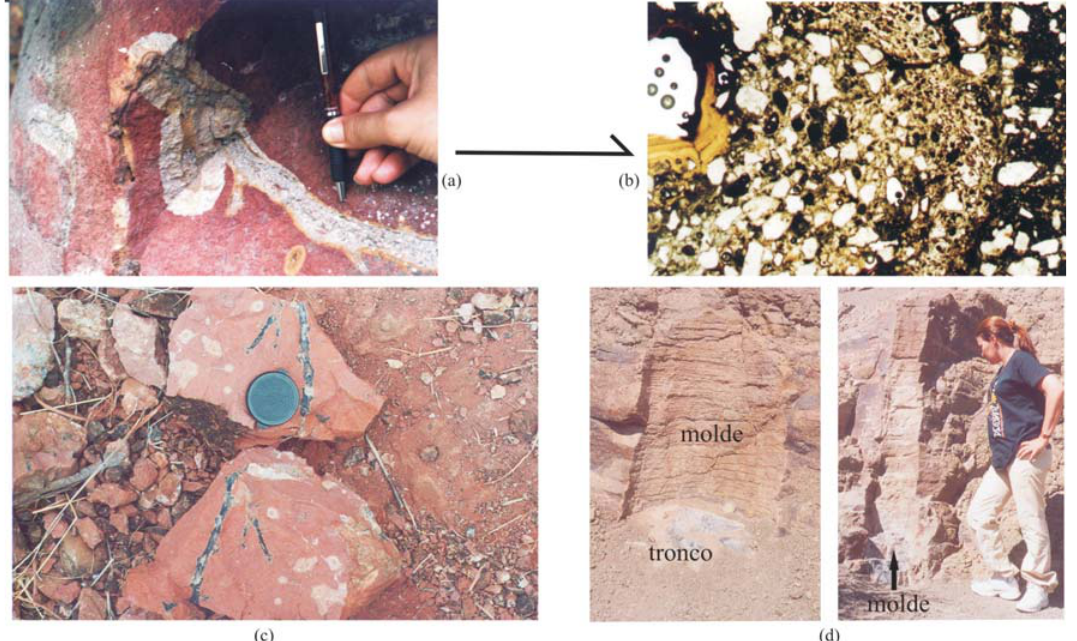
Figura 4. (a) Marca de raízes apresentando halos de redução (Formação Itaqueri, Paleógeno, São Pedro, SP); (b) Fotomicrografia da marca de raiz anterior apresentando no centro cutan de iluviação e halo com esqueleto orientado (LN, 2,5x, sem impregnação); (c) Marcas de raízes na Formação Marília (Cretáceo, Itajá, GO); (d) Tronco de conífera do Triássico na região de Uspallata, Argentina. Estes troncos estão em posição de vida (as árvores foram soterradas vivas por fluxos piroclásticos), o que os tornam excelentes indicadores da presença de paleossolos em sua base.